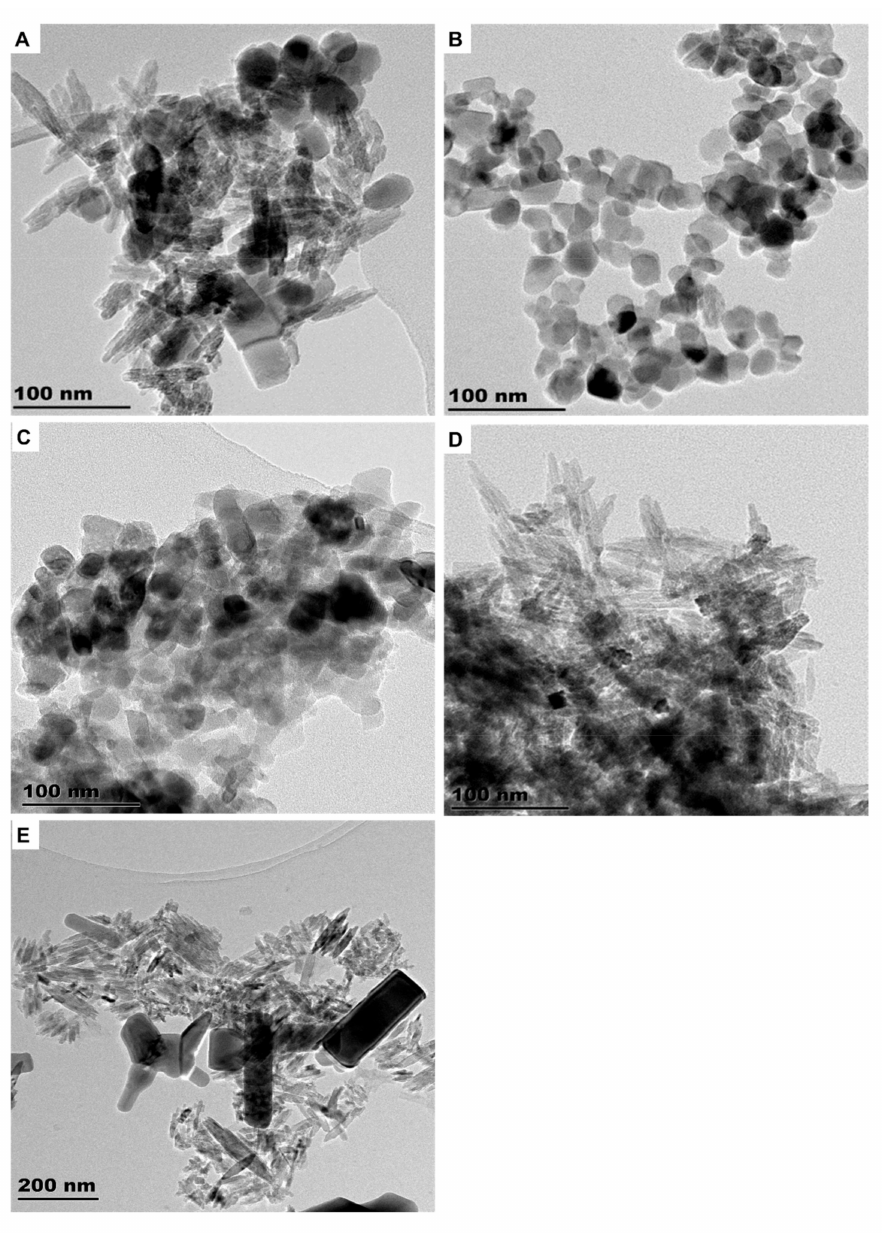
Figure 1. TEM images of engineered nanomaterials (ENMs) found in SUN1 ( A ), SUN2 ( B ), SUN3 ( C ), SUN4 ( D ), and SUN5 ( E